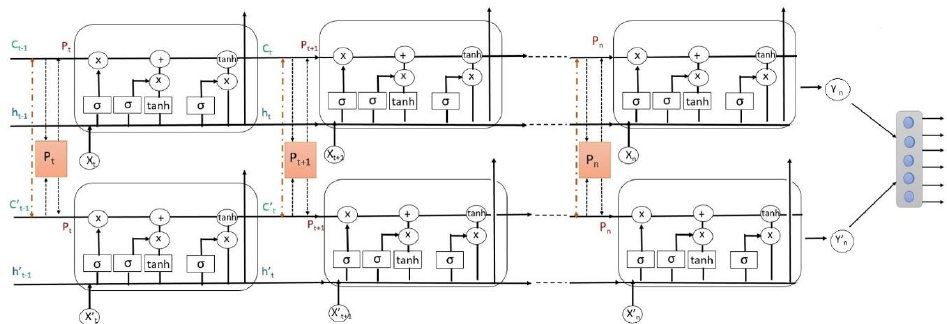
Figure 2. Process of state-exchanging package ( P t ) working with the sequence of LSTMs. First, get both previous cell state values C t − 1 and C (cid:48) of RGB and optical flow stream, average the value t − 1